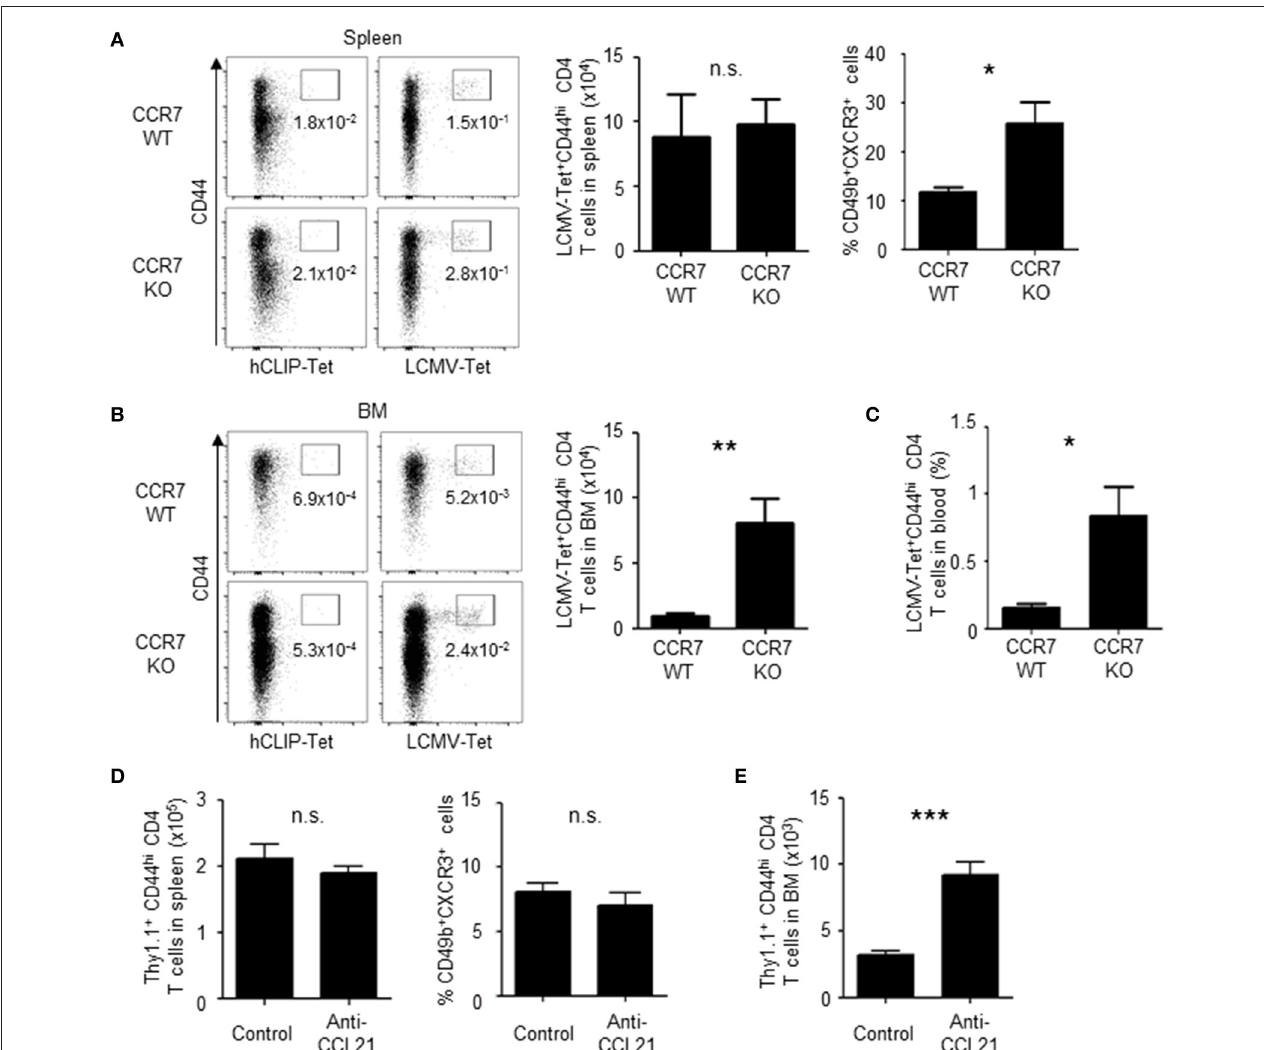
FIGURE 5 | Loss of CCR7 enhances the differentiation of BM memory precursors and the migration of activated CD4T cells into the BM. (A–C) A deficiency of CCR7 increases the migration of memory precursors into the BM. CCR7 WT or KO mice were immunized twice with LCMV-gp61 and LPS and on day 6 after the second immunization analyzed for the enumeration of LCMV GP-specific CD4T cells in the spleen (A) , BM (B) and peripheral blood (C) by LCMV GP-specific MHC class II tetramer staining. Dot plots show the expression of CD44 and binding of LCMV GP-specific tetramer or control tetramer (hCLIP) in CD4 + B220 − NK1.1 − PI − cells. Bar charts show the numbers and frequencies of LCMV-tetramer positive CD44 hi CD4T cells (A–C) and the frequency of CD49b + CXCR3 + cells within splenic LCMV-tetramer positive CD44 hi CD4T cells (A) n = 9. (D,E) Blockade of CCL21 increases the migration of memory precursors into the BM. Mice transferred and immunized as described in Figure 1 were injected intraperitoneally with 50 µ g anti-CCL21 or isotype control on day 5 after immunization. Numbers of total Thy1.1 + CD4T cells and the frequency of the CD49b + CXCR3 + subpopulation in the spleen (D) and numbers of total Thy1.1 + CD4T cells in the BM (E) on day 6 after immunization are shown n = 4. These data are representative of two independent experiments. Data are shown as mean ± SD. * p < 0.05, ** p < 0.01, *** p < 0.001, n.s.: not